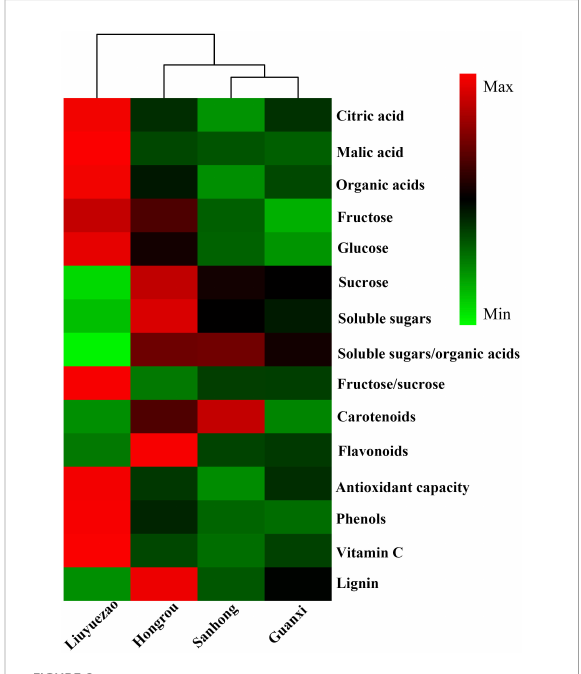
FIGURE 2 HCA of sensory and nutritional pro fi les in pulp samples from the four pummelo